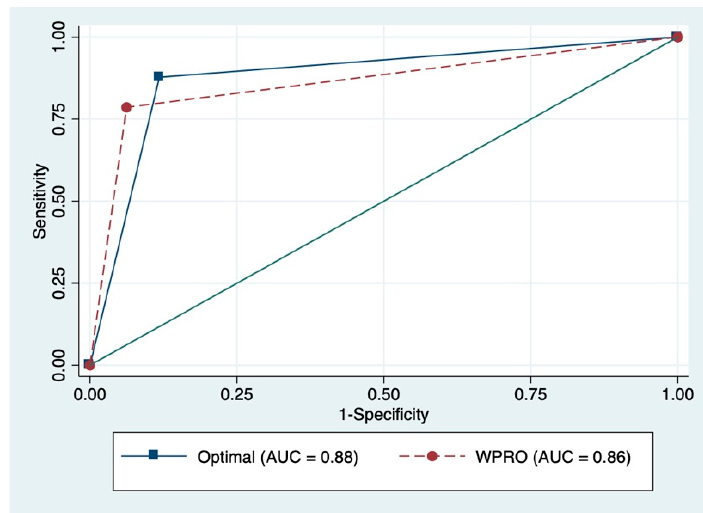
Figure 2. ROC curves and corresponding AUC among female Indonesian participants.